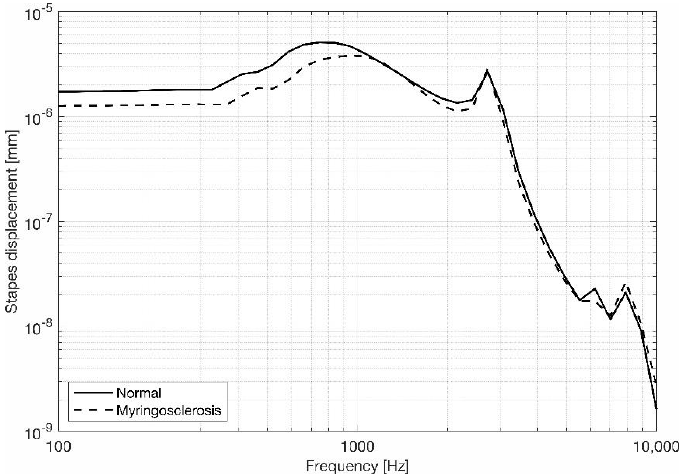
Figure 8. Stapes footplate displacements ’ magnitude, comparing the model that was representative of a normal ear and myringosclerosis.